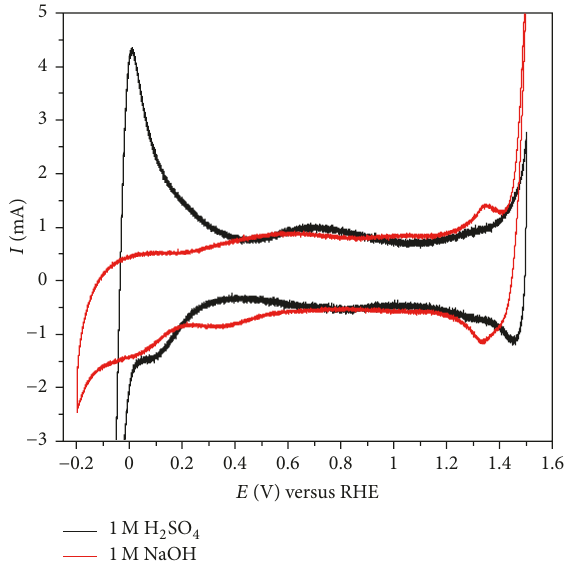
Figure 2: Cyclic voltammogram of a Ti/RuO 2 electrode in 1M H 2 SO 4 and1 MNaOHat25 ∘ C.Counterelectrode:Ptsheet.Scanrate: